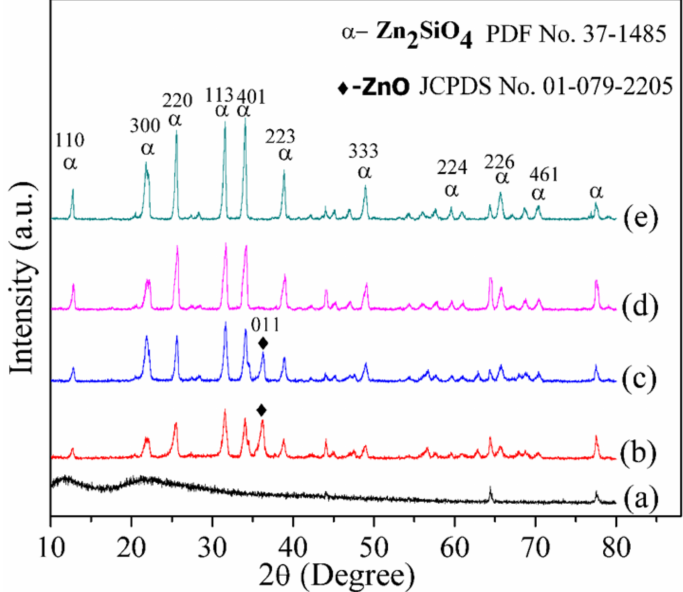
Figure 4. X-ray diffraction (XRD) of ( a ) uncalcined sample and willemite NPs calcined at 900 ◦ C over a